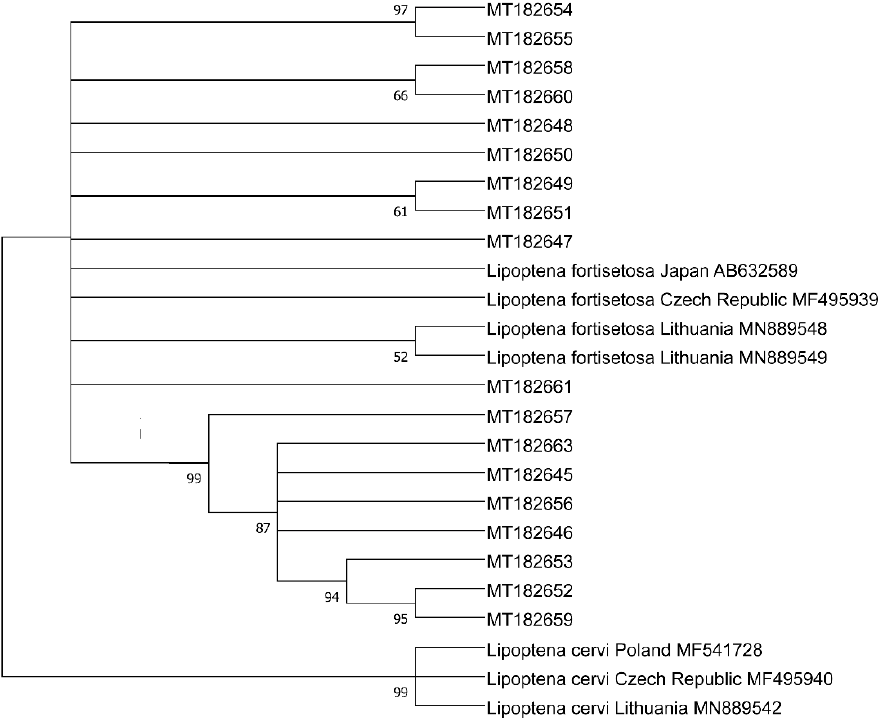
Figure 2. Phylogenetic analysis of the rRNA 16S gene in Lipoptena fortisetosa . Legend: phylogenetic tree based on the results of the maximum likelihood analysis of a fragment of the rRNA 16S gene in Lipoptena fortisetosa . The identified unique haplotypes are labeled with sequence identification numbers. The reference sequences from GenBank are indicated in the tree. Bootstrap confidence values for assessing the reliability of branches were calculated in 10,000 replicates. Table 2. Comparison of the acquired sequences with GenBank sequences.